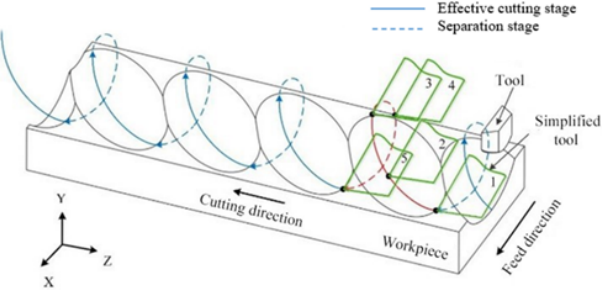
Figure 3. The IASGSO optimized solution versus the number of iterations for (a) ˆ λ 2 and ˆ λ 3 and (b) ρ 2 and ρ 3